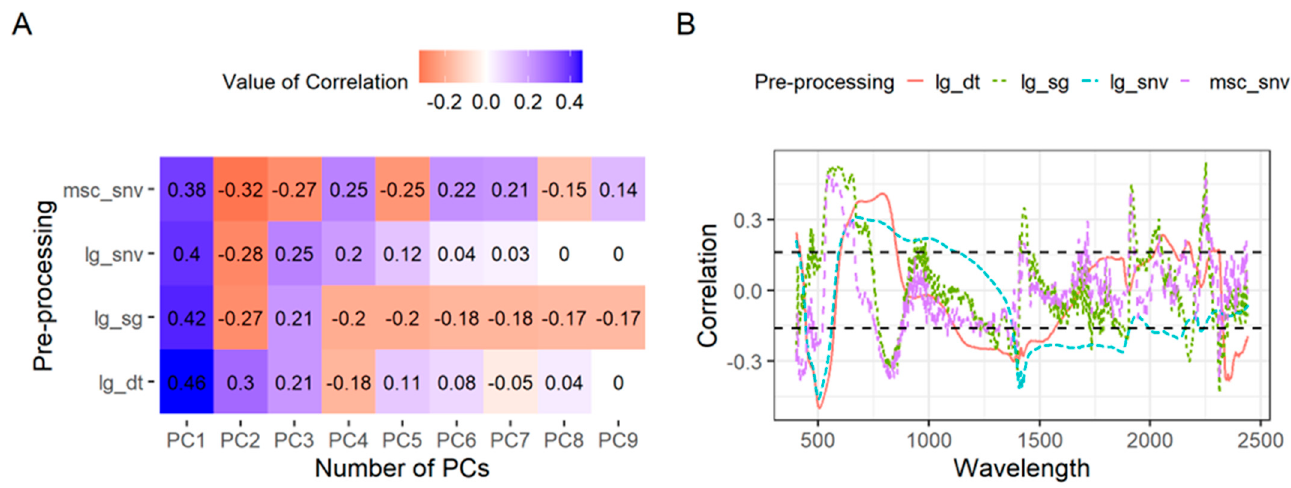
Figure 4. The correlation of SOM with principal components (PC1:PC9) calculated from the spec- troscopy reflectance R with four preprocessing methods ( A ) and of SOM with spectra with four